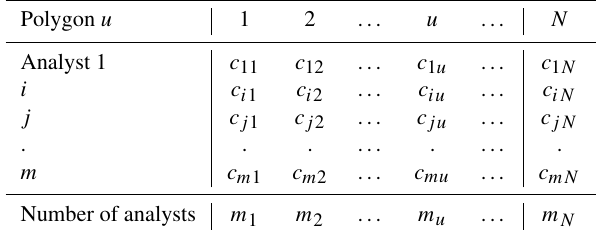
Table 2. Reliability data matrix. This table is used to create the co- incident